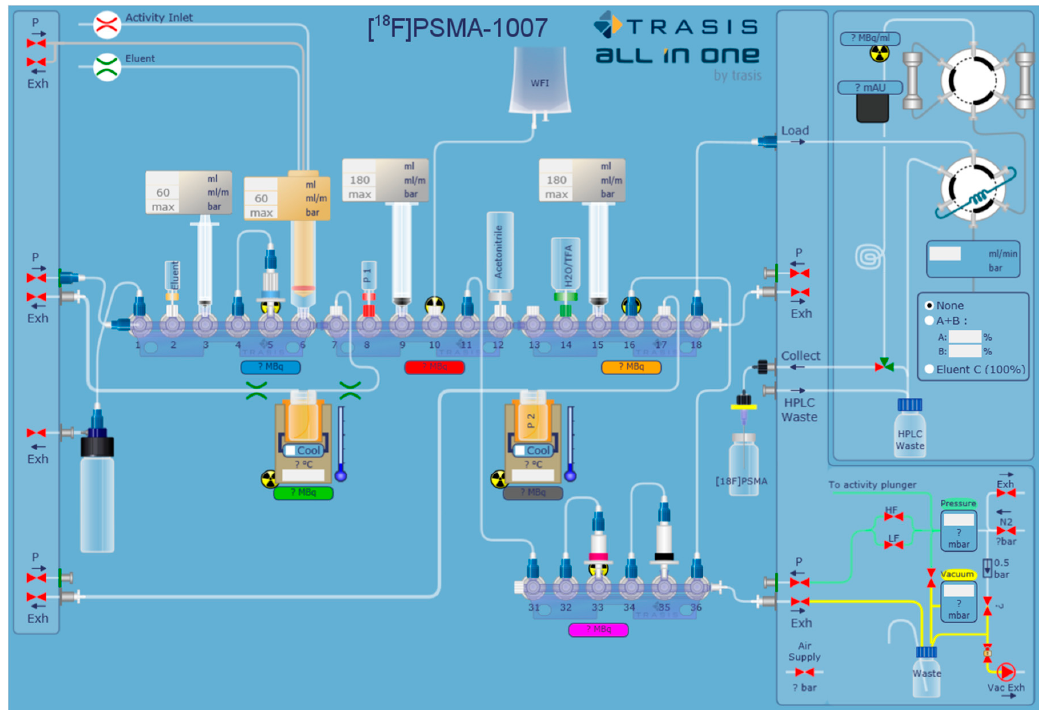
Figure 6. General setup of the synthesis cassette for two-step production of [ 18 F]PSMA-1007 with HPLC purification on AllInOne (Exh: Exhaust to vacuum pump).